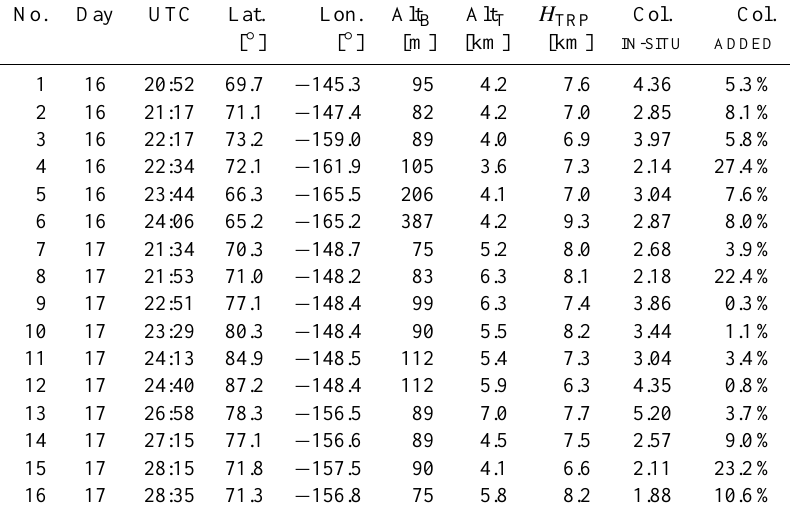
Table 1. Information for NASA DC-8 BrO profiles shown in Fig. 1. “Day” means day of April 2008. Alt B (Alt T ) means the bottom (top) altitude of the profile. “Col.” stands for BrO vertical column density (VCD). Units of BrO VCD are 10 13 moleculescm − 2 . “Col. ADDED ” is the estimated amount of BrO that was added to the measured in-situ column to provide an estimate of the complete tropospheric column.